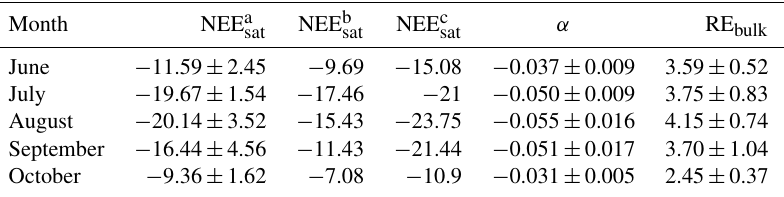
Table 2. The ecosystem photosynthesis parameters using Eq. (1) (NEE sat : µmolm − 2 s − 1 , α : µmolm − 2 s − 1 , R 2 ) and NDVI for each month during the wet seasons from 2012 to 2015. The regression was based on the average values of NEE daytime and PAR with PAR bins of 100µmolm − 2 s − 1 . NEE ( a ) sat represents the mean value and the standard deviation, NEE ( b ) sat and NEE ( c ) sat represent the maximum and minimum values of NEEsat for each month. Month NEE a sat NEE b sat NEE c sat